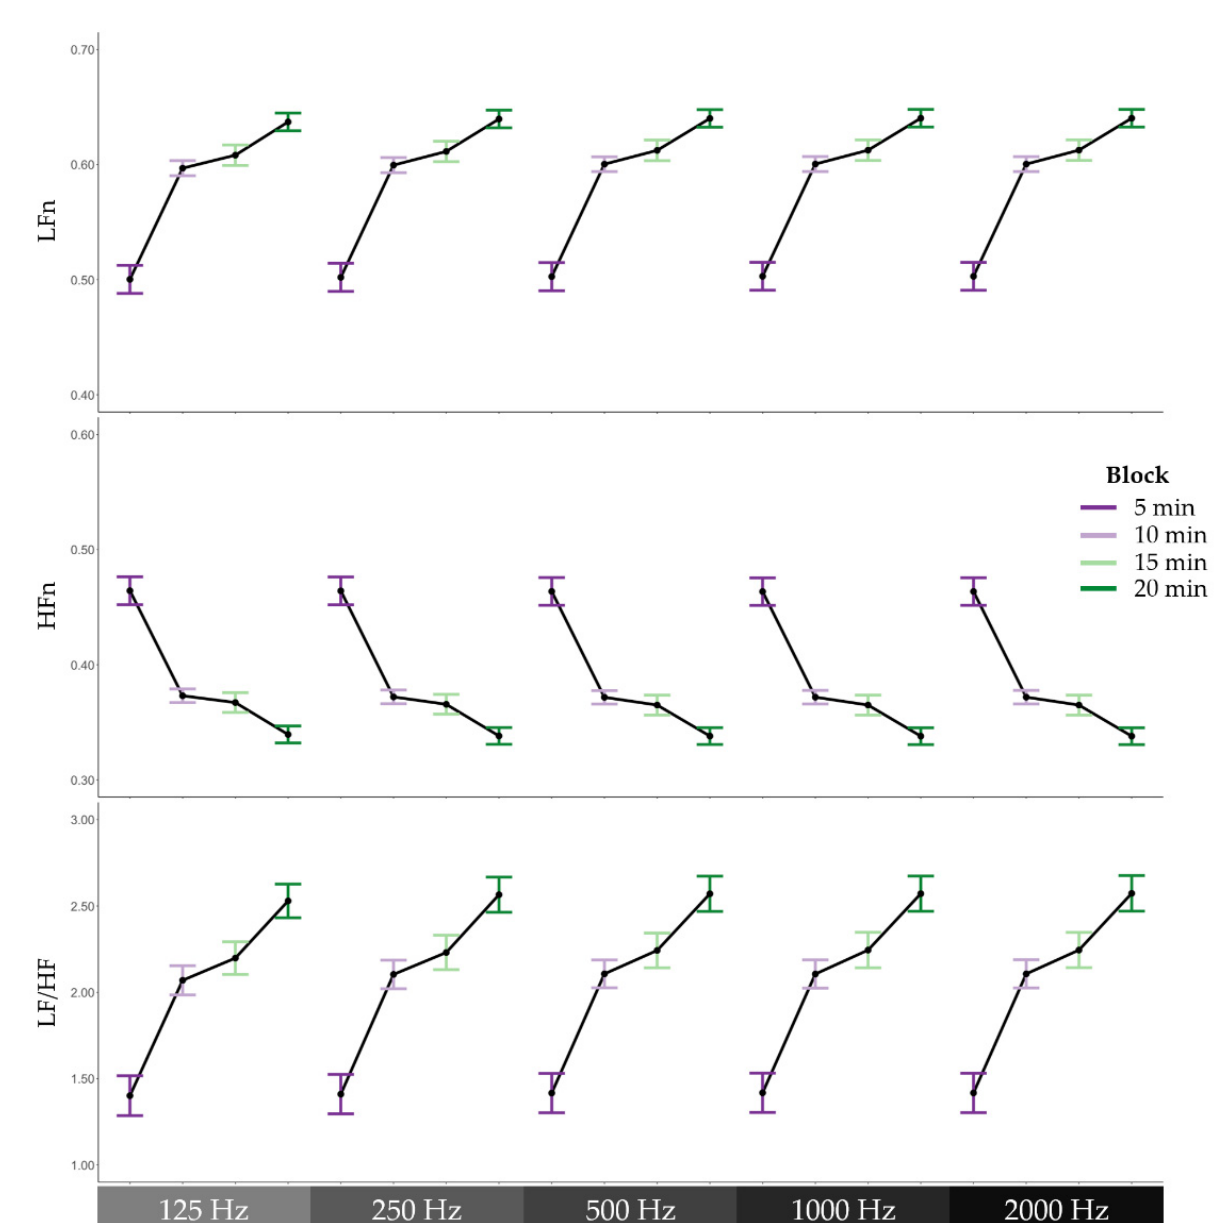
Figure 5. Frequency domain heart rate variability features across 5-min blocks during the cognitively fatiguing task. From top to bottom, means and standard errors of low-frequency power normalised to total power (LFn), high-frequency power normalised to total power (HFn), and the ratio of low-frequency power to high-frequency power (LF/HF), and from left to right, the different sampling rates, 125 Hz, 250 Hz, 500 Hz, 1000 Hz, and 2000 Hz.